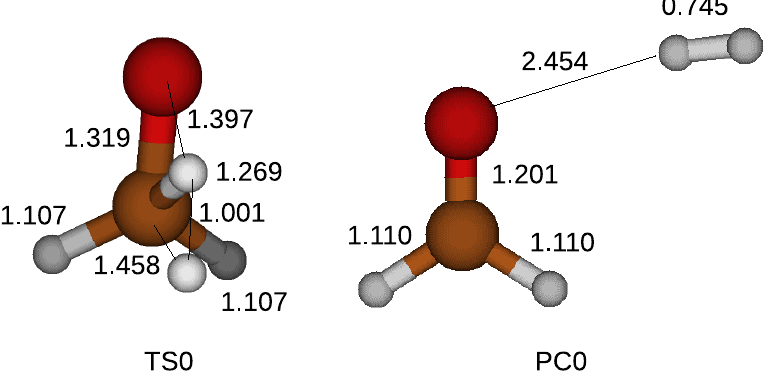
Figure 2. Optimized structure of a transition state for the oxidation of a CH H O molecules. Thin solid lines are added in the transition state to present the lengths between atoms 2 in Å. A product compound is displayed as well. TS0 and PC0 stand for a transition state and a product compound for the oxidation of a CH OH without any 3